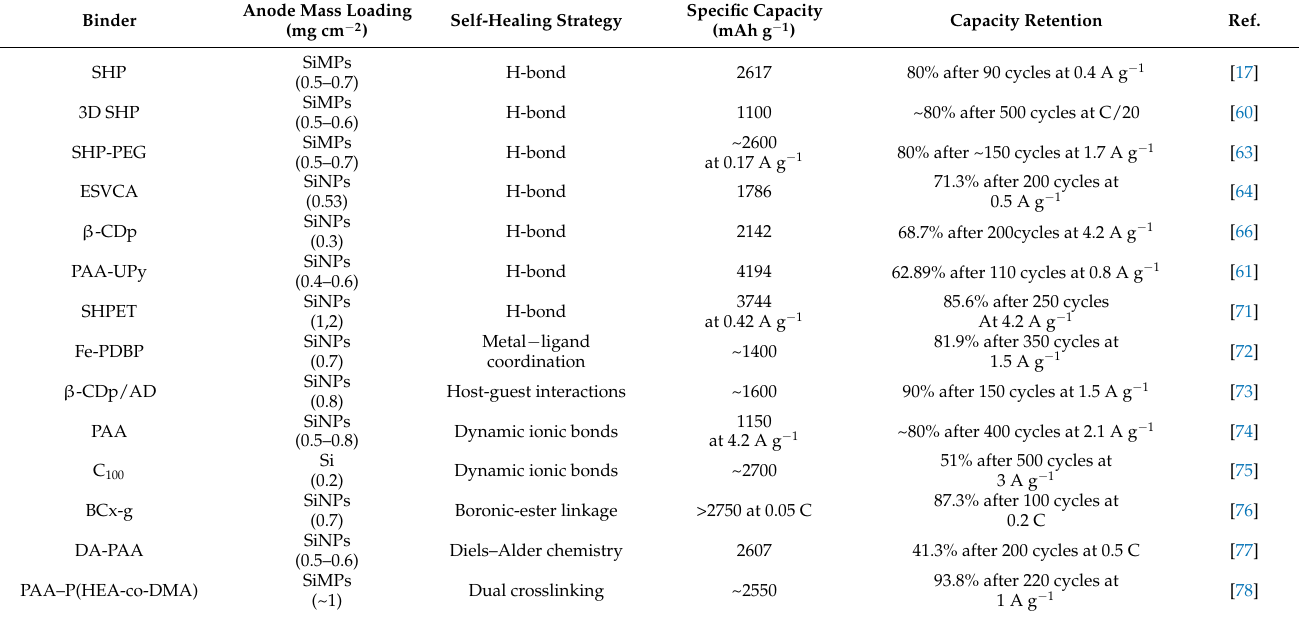
Table 1. Summary of the self-healing binders used in Si anodes reviewed